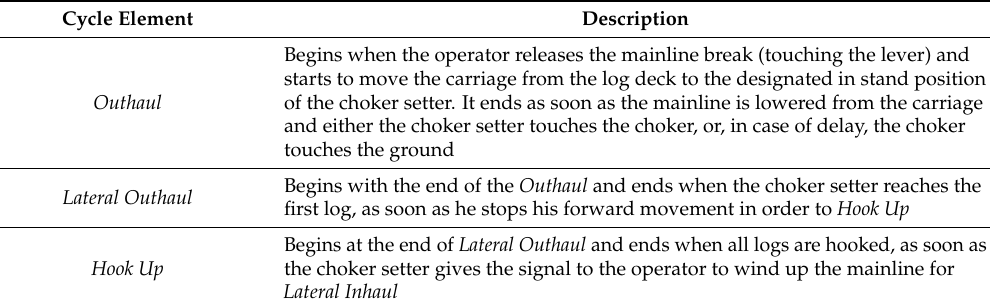
Table 3. Description of Cycle Elements of the Yarding